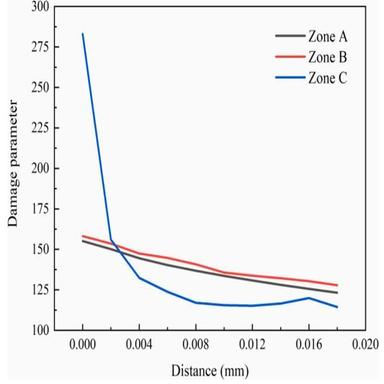
The FP damage parameter distribution along θ = 45◦ line in three